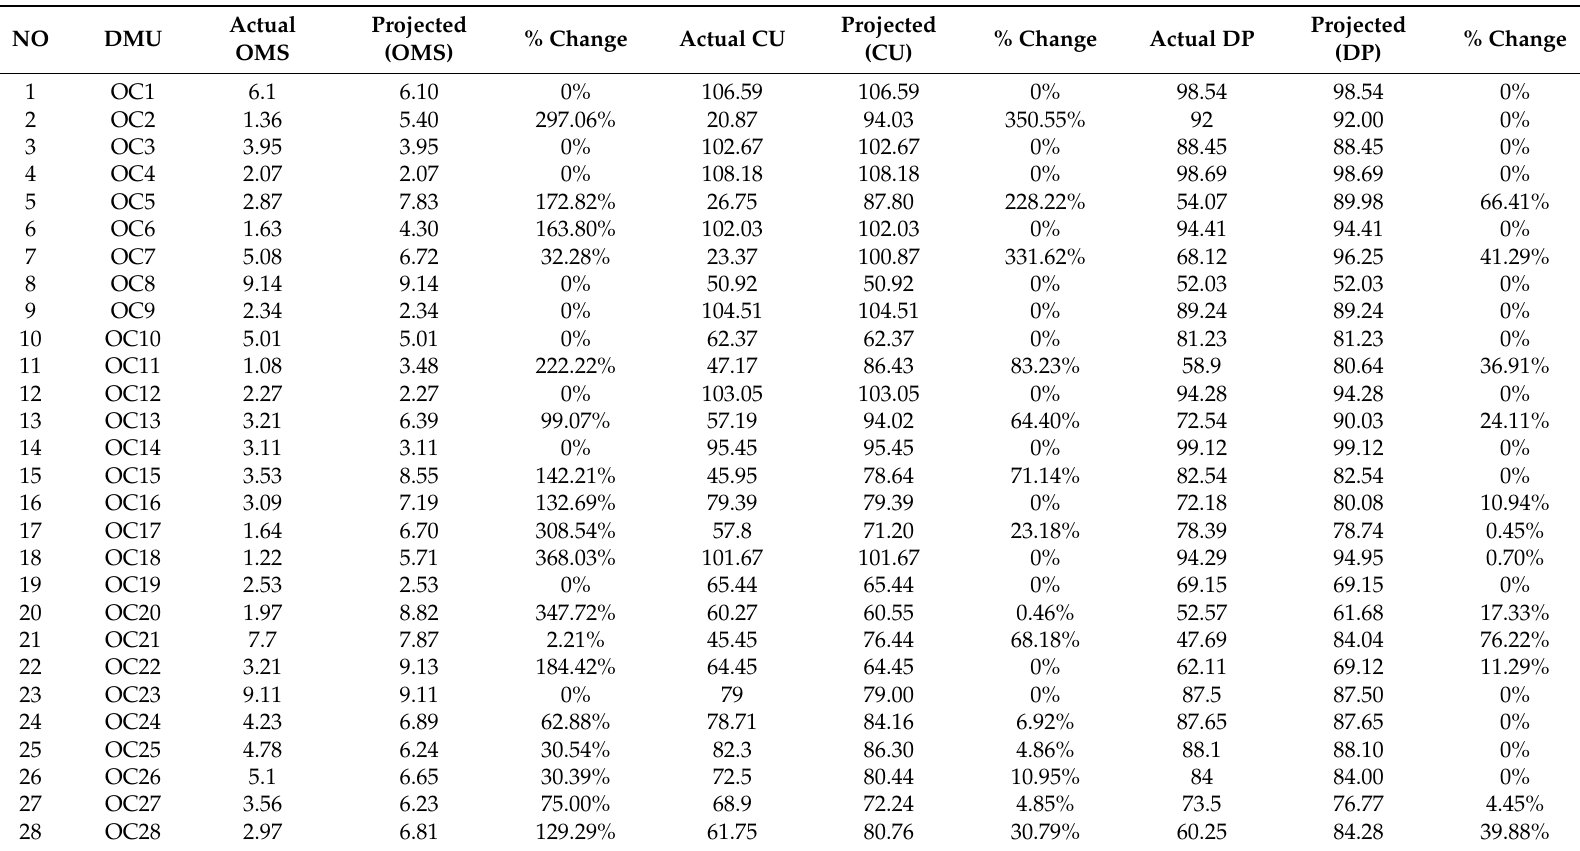
Table A5. Comparisons between the actual and projected value with percentage improvement of output variables of opencast mines using VRS